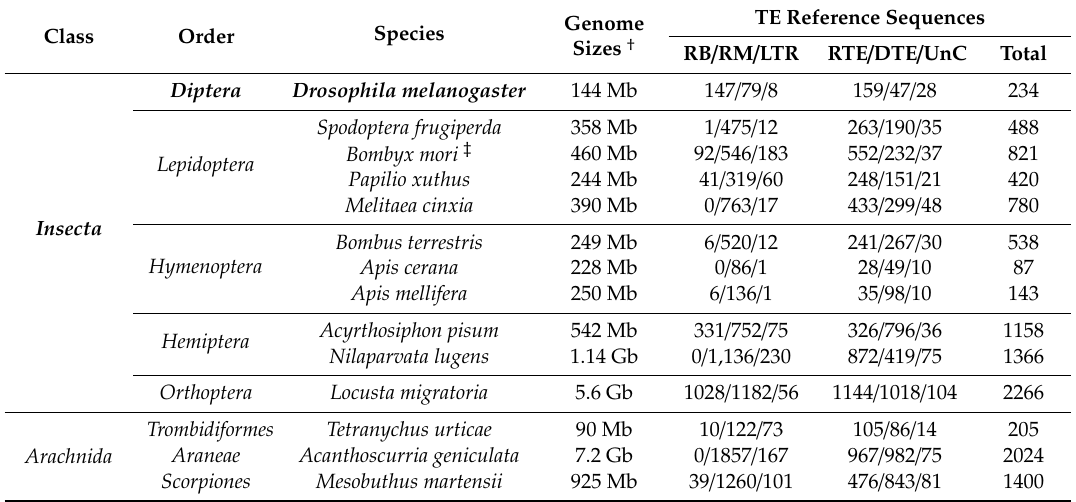
Table 1. Genome sizes and the number of transposable elements references of fourteen